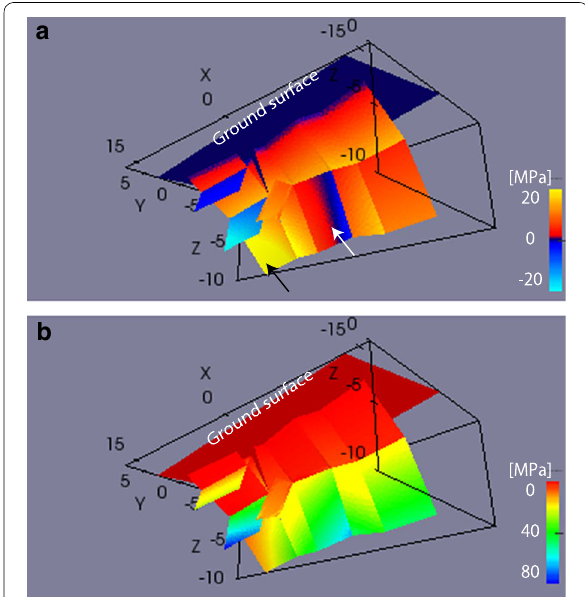
Fig. 6 Distribution of the potential stress drop ( a ) and the strength excess ( b ) for Model S. Looking up from